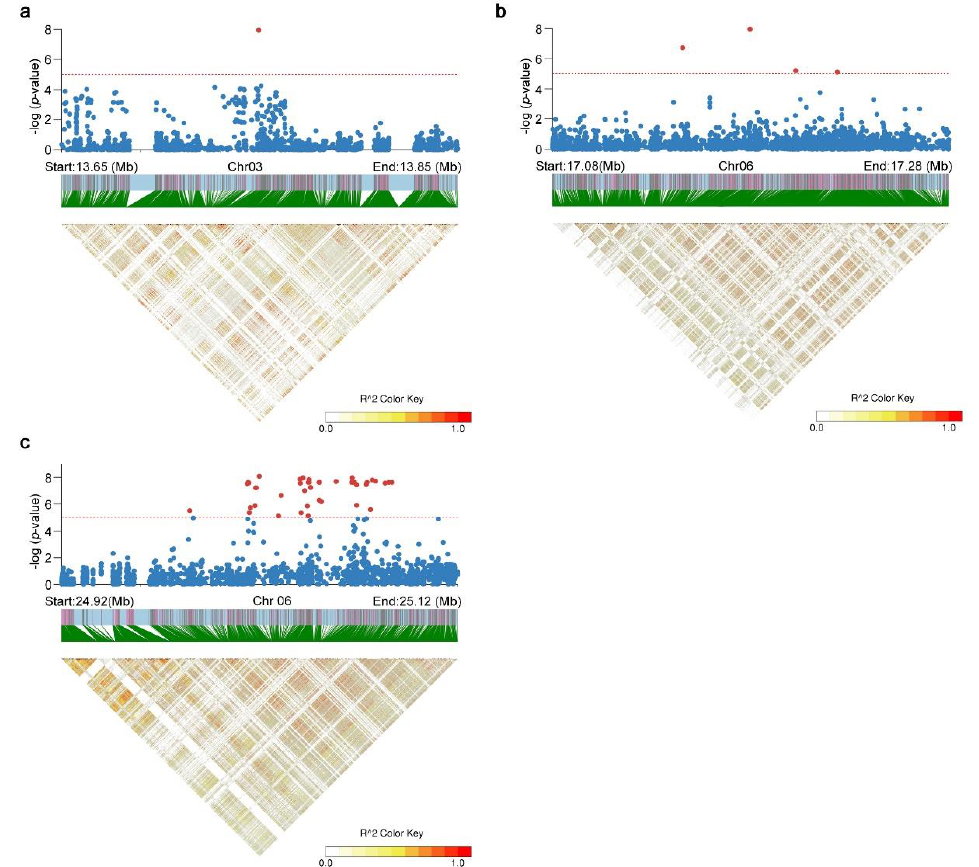
Figure 4. Local Manhattan plot (top panel) and LD heatmap (bottom panel) of the 13.65–13.85 Mb region of chromosome 3 ( a ), 17.08–17.28 Mb region of chromosome 6 ( b ), and 24.91–25.11 Mb region of chromosome 6 ( c ).